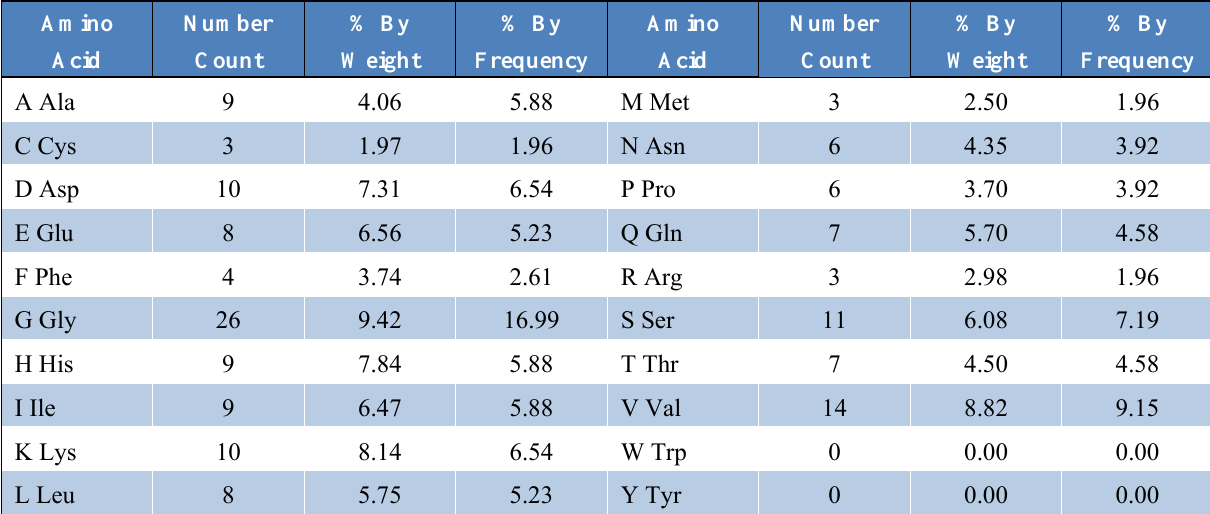
Table 1. Predicted chemical composition of the cloned fragment of cSOD1 using Protean program.